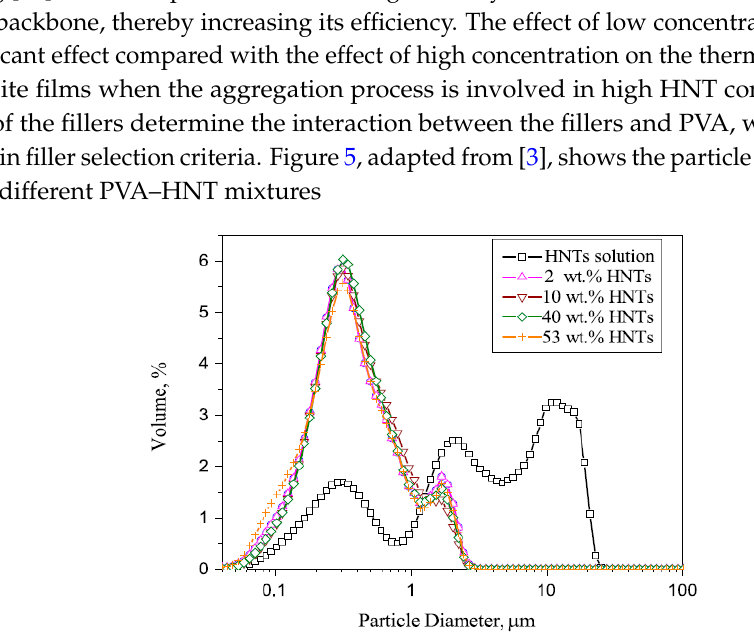
Figure 5. The particle size and distribution of HNTs in mixture of PVA-HNTs [3].